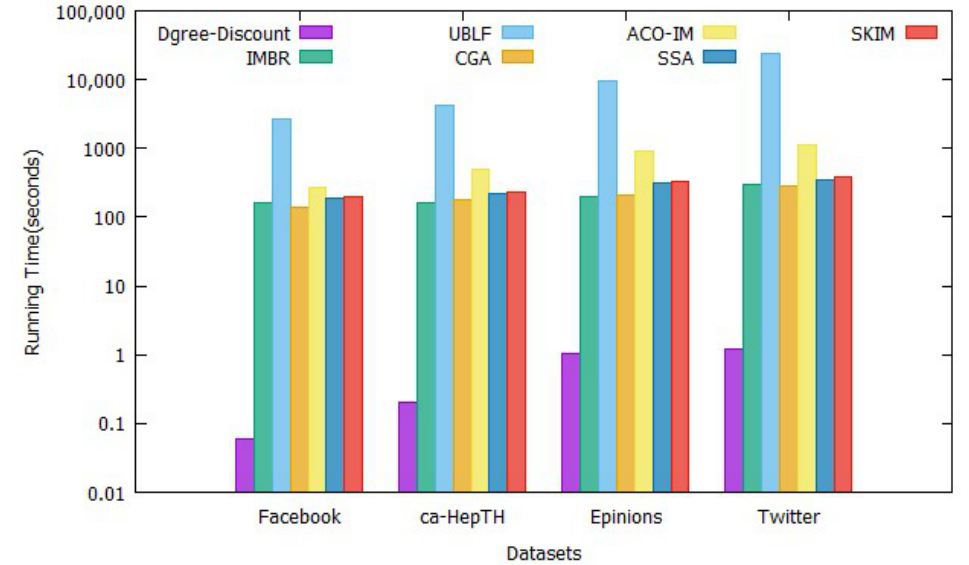
Figure 4. Comparison of running time between IMBR and other six rival algorithms.